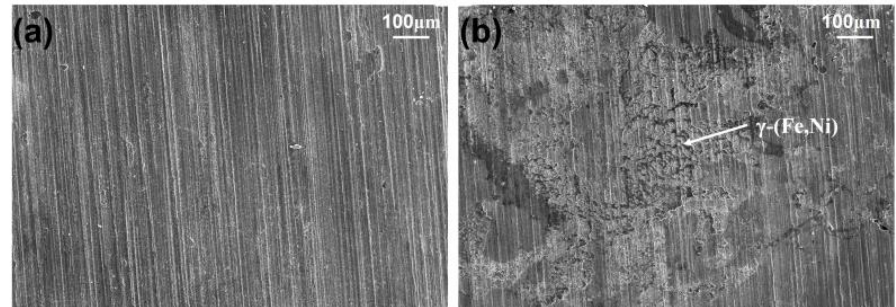
Figure 19. Surface topographies of LCC specimens. ( a ) No. 3; ( b ) No. 4.